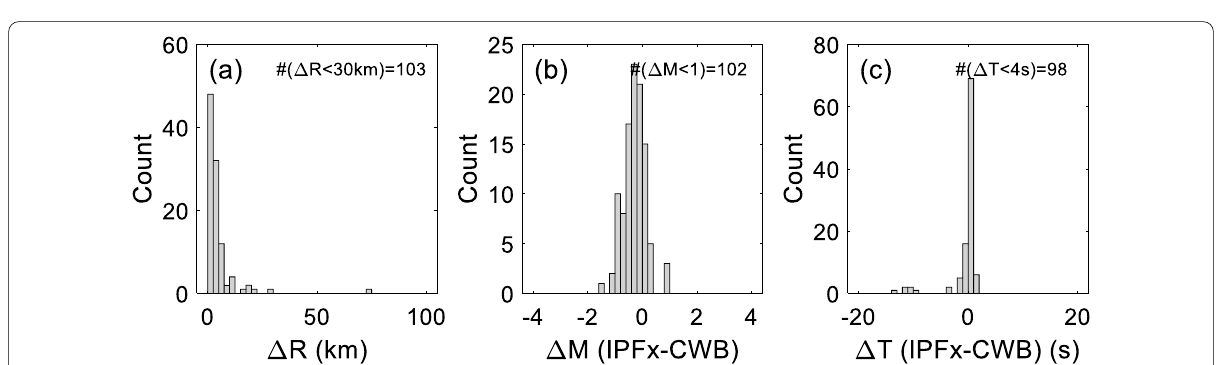
Fig. 8 Histograms of ( a ) location, ( b ) magnitude, and ( c ) origin time errors for earthquakes with SI convergence time and the CWB manual catalog are shown. The top‑right numbers show the number of earthquakes with an error value below the